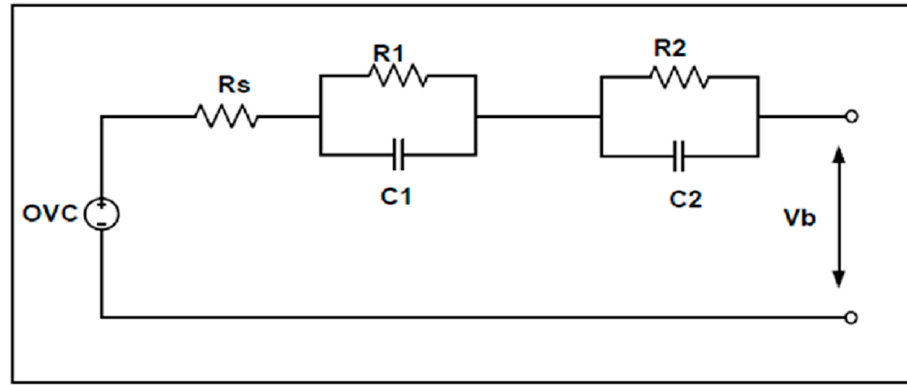
Figure 2 . Battery equivalent circuit model, Reproduced from [31], MDPI Batteries: 2019. Figure 2. Battery equivalent circuit model, Reproduced from [31], MDPI Batteries: